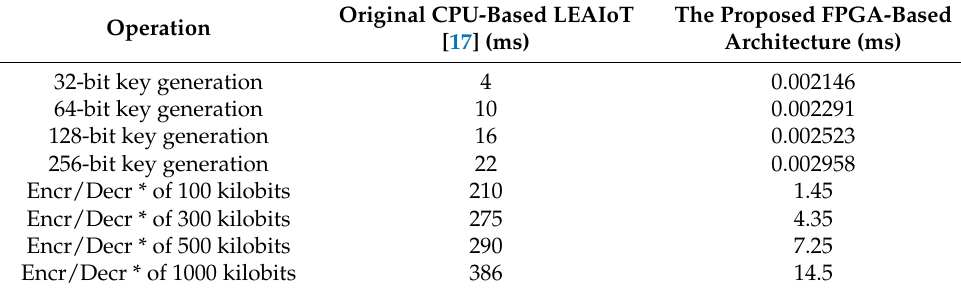
Table 3. Performance comparisons with the original design in [17].